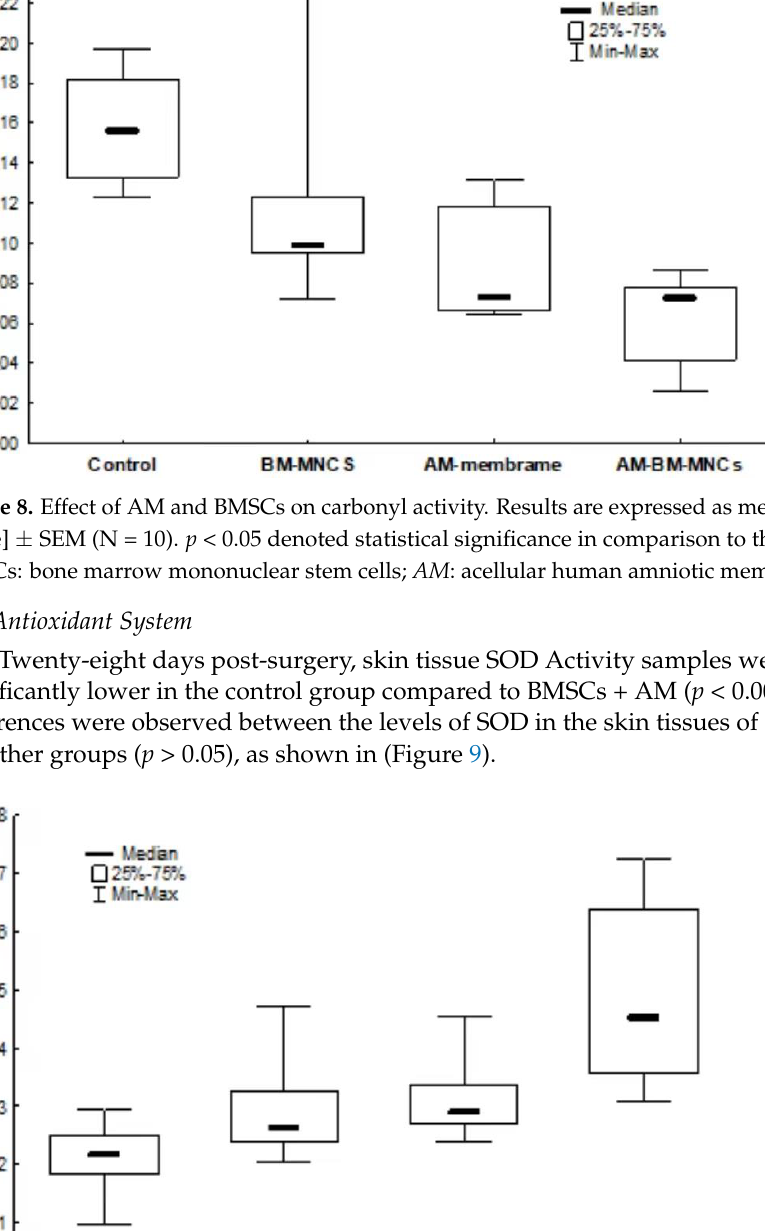
amniotic membrane.